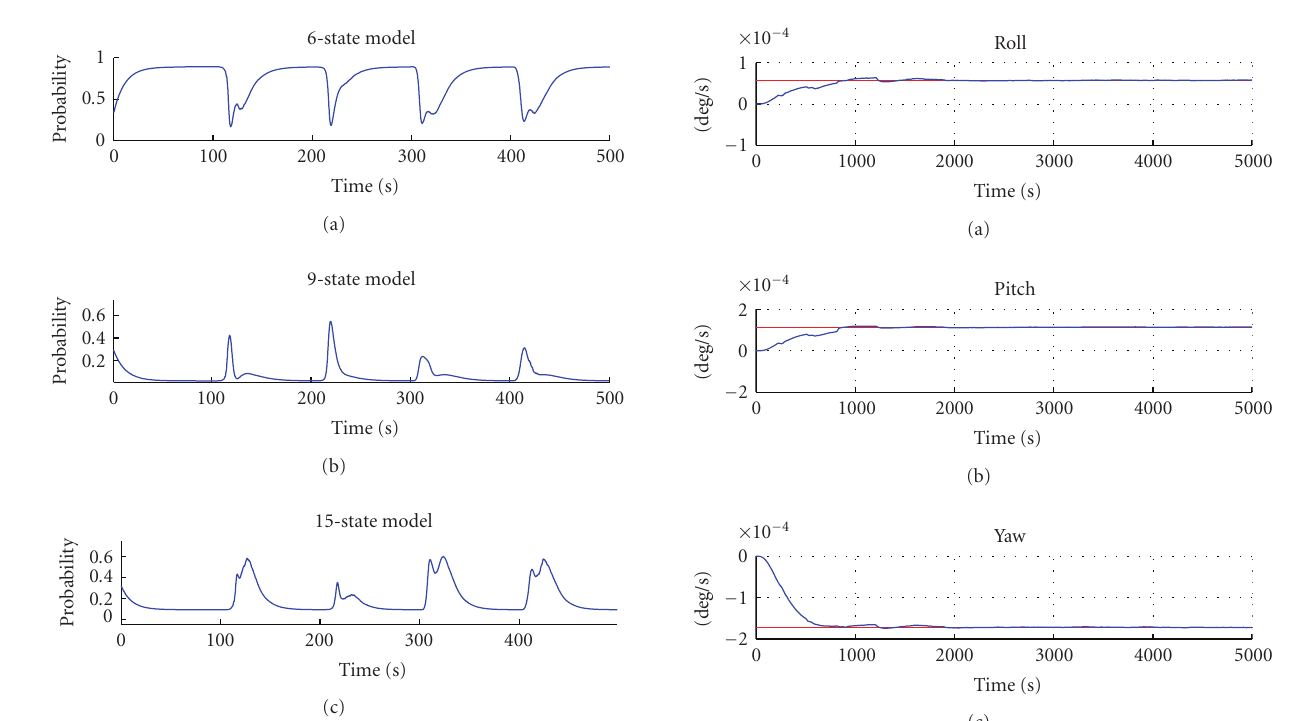
Figure 10: Posterior probability of the EKFs structures in IMM CT method. Table 3: Di ff erent model for star sensor measurement noise levels. Number of